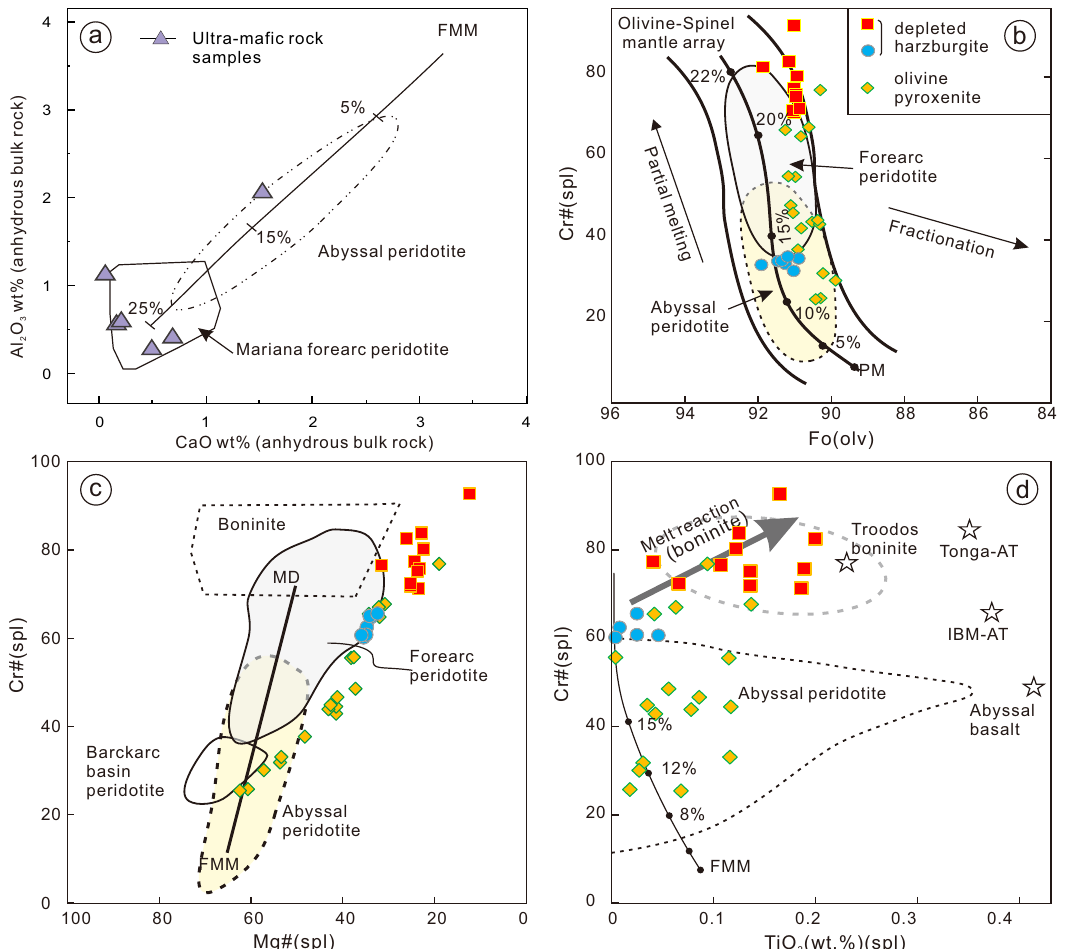
Fig. 4 Tectonic discrimination diagrams for the ophiolitic peridotites. a Bulk-rock abundances of Al 2 O 3 vs. CaO (volatile free, normalized to 100% total), showing how melting depletes peridotites in these elements. b Cr# (Cr/Cr + Al) vs. Mg# (Mg/Mg + Fe + 2 ) diagram for composition of spinels in peridotite. c Compositional relationship between Cr# of spinel and Fo [100 Mg/(Mg + Fe 2 + )] content of coexisting olivine in peridotite samples. d Compositional variations of Cr# vs. TiO 2 (wt%) content of spinels in peridotite samples of the Munabulake ophiolite. Fields for passive margin, abyssal and forearc peridotites and degrees of melt extractions can be found in 31,55 and references therein. FMM Fertile midocean-ridge basalt (MORB)-type mantle, PM Primitive